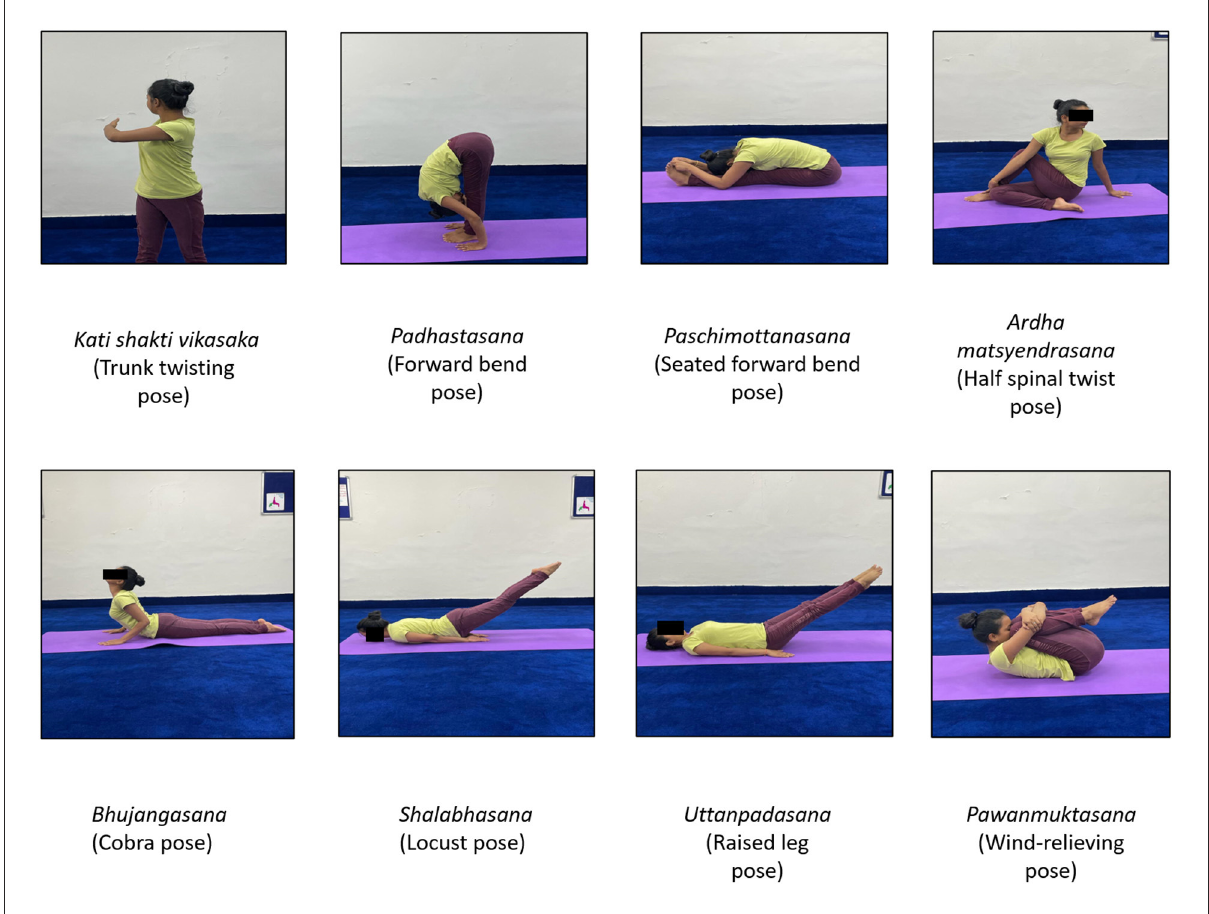
FIGURE2 Images showing different Yoga-practice